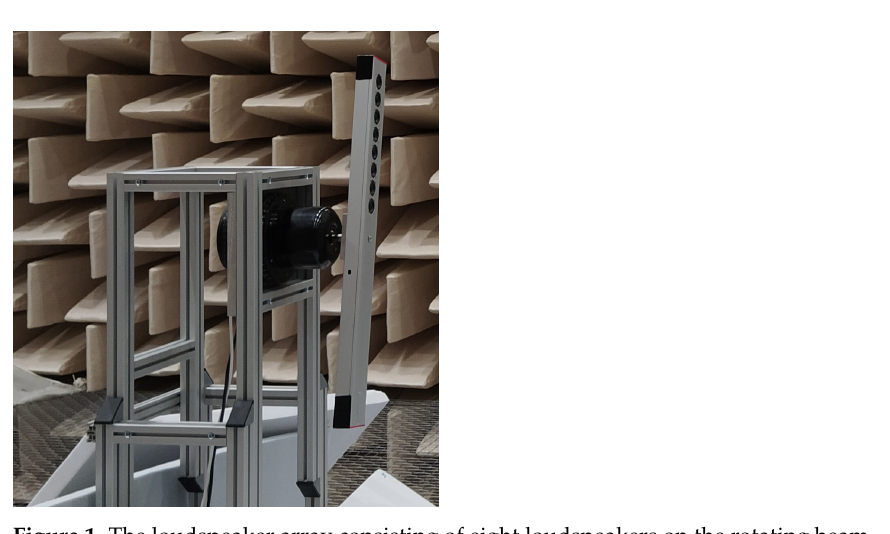
Figure 1. The loudspeaker array consisting of eight loudspeakers on the rotating beam. Table 1. Experimental data acquisition and processing parameters.